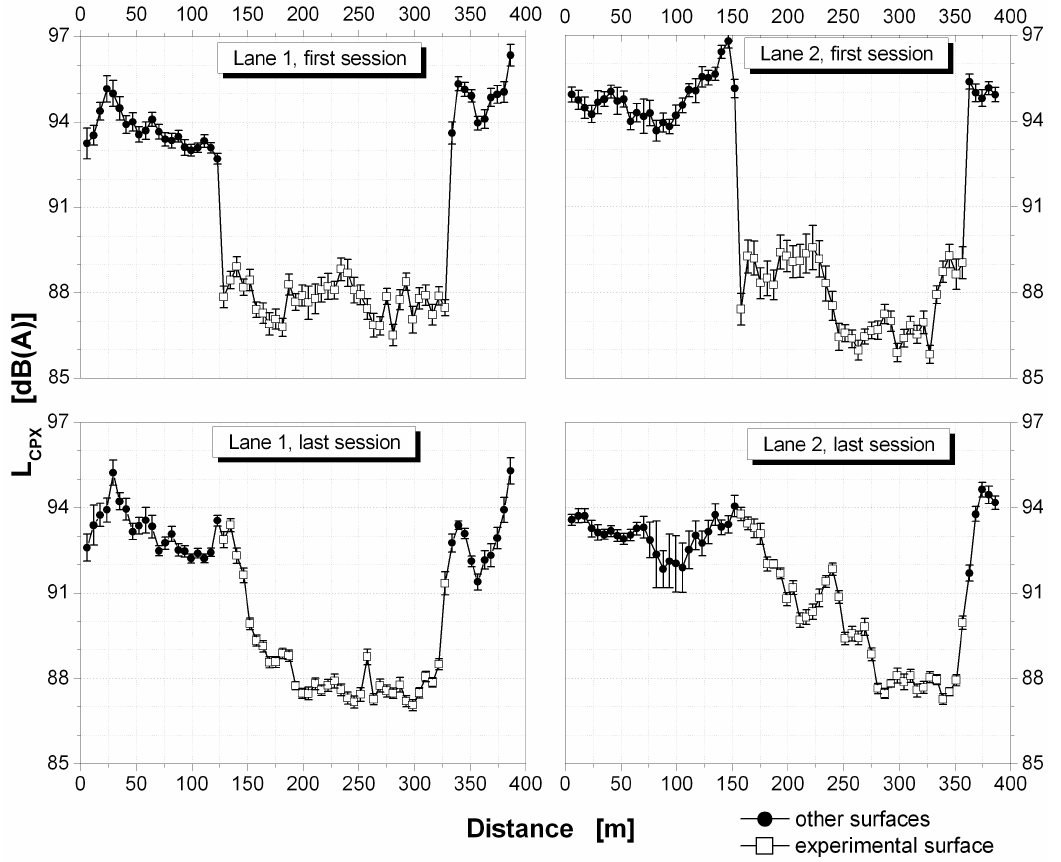
Figure 17. CPX data spatial distribution obtained during first session (upper figures) of measurements and during last one (lower figures) at Site 5. Lane 1 results are represented on the left plots while lane 2 ones are on the right plots. Experimental stretches data are marked with white